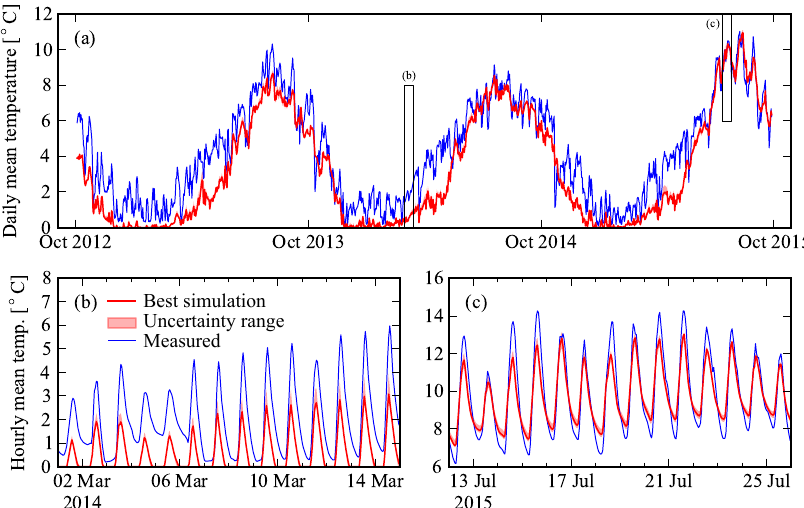
Figure 9. Comparison between the simulated (red line) and measured (blue line) time evolution of stream temperature at the catchment outlet. Panel (a) pictures the entire simulated period (hydrological years 2013 to 2015), with temperature aggregated into daily mean values for visibility. Panels (b) and (c) display the hourly mean temperature over two selected periods of 14 days (their respective extents are indicated as black rectangles in panel a ). The simulated curve was obtained with StreamFlow based on the instantaneous water routing scheme, with the temperature of the subsurface water flux being approximated as the soil temperature averaged over a depth of 2 . 40m. The uncertainty range (displayed in light red) is obtained by evaluating StreamFlow for each one of the 300 best sets of parameters R max , τ res,u and τ res,u identified during calibration step 1 (see Sect.